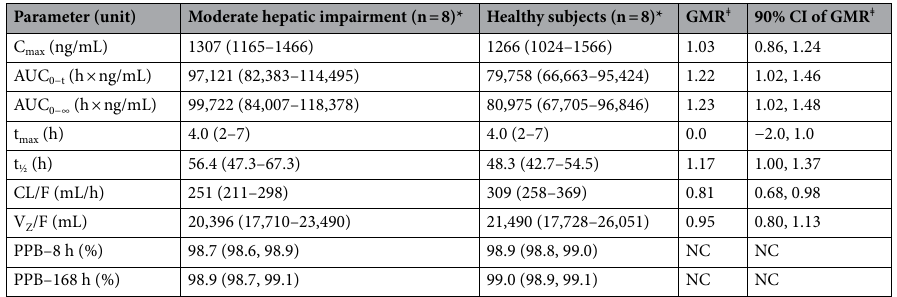
(Table 2). There was no difference between groups in C max as indicated by a GMR of C max (90% CI) of 1.03 (0.86–1.24). After reaching C max , aprocitentan concentrations decreased slowly in both groups as indicated by a t½ of 56.4 h and 48.3 h, respectively. The apparent clearance, CL/F, in subjects with moderate hepatic impair- ment was lower (251 mL/h) compared to that of healthy subjects (309 mL/h). The apparent volume of distribu- tion, V Z /F, was similar between groups (20.4 L and 21.5 L in subjects with moderate hepatic impairment and in healthy subjects, respectively). Overall, this resulted in higher exposures in terms of AUC 0−t and AUC 0−∞ of 22% and 23%, respectively. The GMRs and 90% CI of AUC 0−t and AUC 0−∞ were 1.22 (1.02–1.46) and 1.23 (1.02–1.48), respectively. Aprocitentan was highly bound to plasma proteins (mainly albumin) in both groups, with PPB values ranging from 98.7 to 98.9% and from 98.9 to 99.0% at 8 and 168 h after dosing, respectively. All PK parameters are summarized in Table 2.